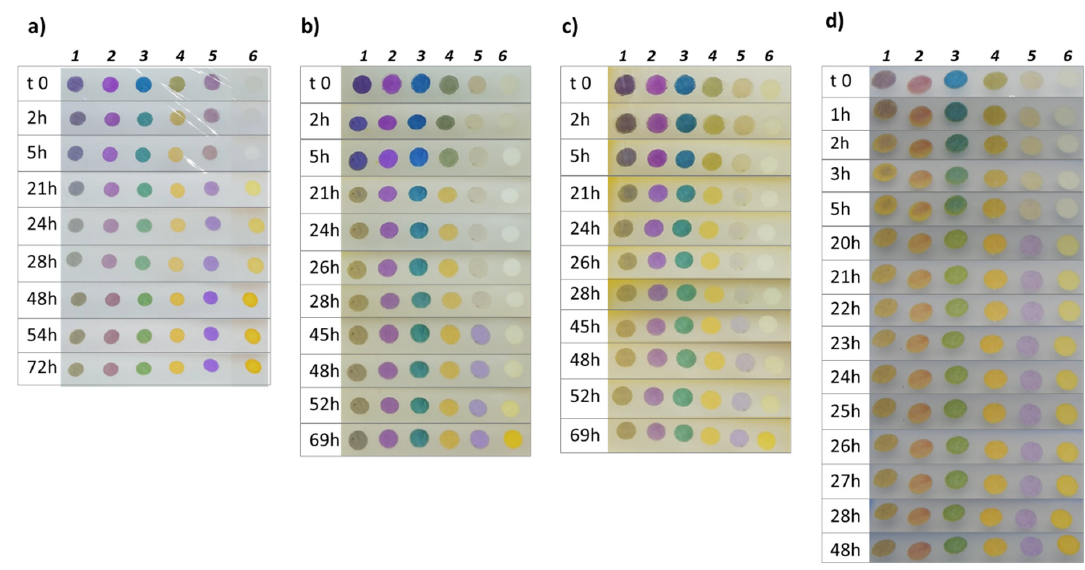
Figure 2. The colour evolution of the sensor arrays over chicken meat ( a ), beef meat ( b ), pork meat ( c ) and cod fillets ( d ) kept at room temperature.